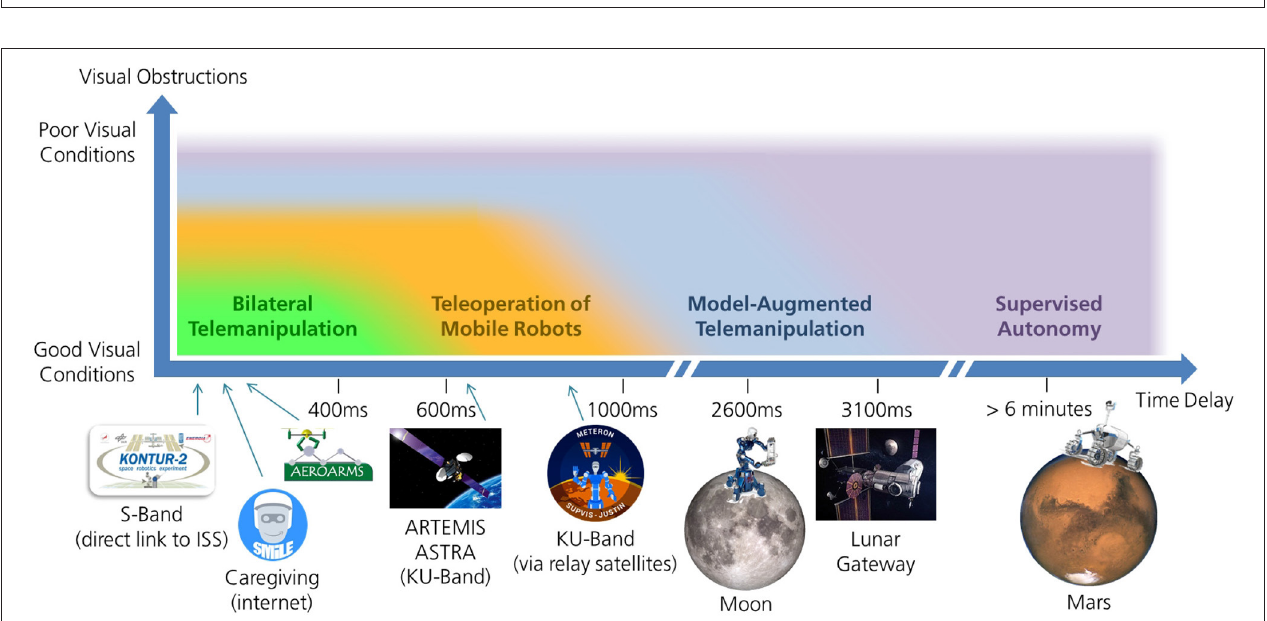
FIGURE 2 | Schematic diagram that illustrates up to which time delay and under which visual conditions different telerobotic concepts can be applied. It also shows the delays that occurred for selected missions from section 3 and use cases from section 4 (credit for photos of the Moon, the Mars, and the gateway: NASA).